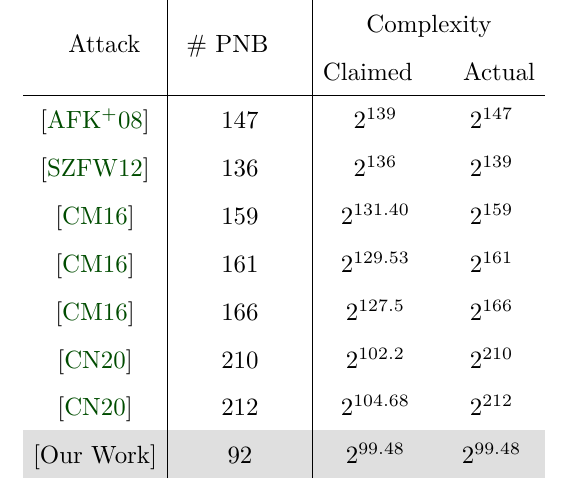
Table 2: Corrected complexities of certain previous key-recovery attacks on 6-round ChaCha256 and our improved